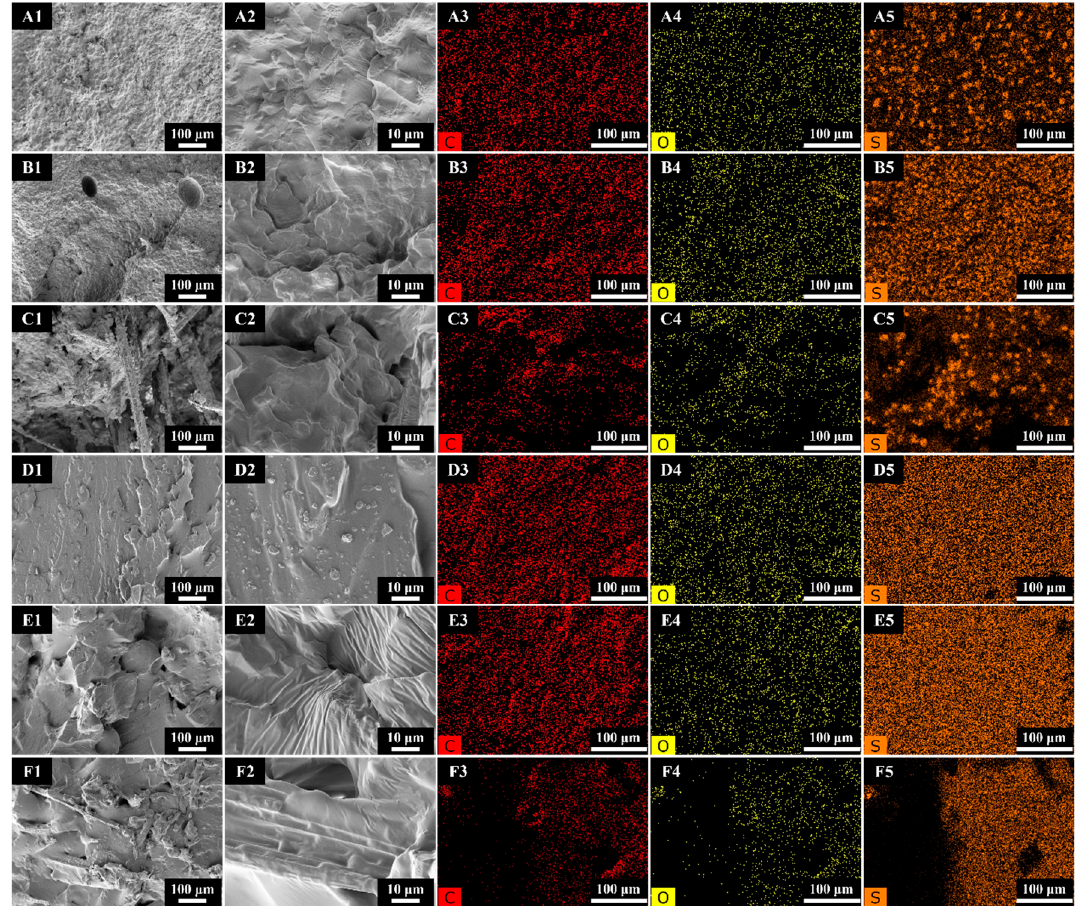
Figure 4. SEM image and element mapping of bio-based polysulfide composite. ( A1 – A5 ) 10.0 g CSO + 10.0 g S, ( B1 – B5 ) 10.0 g CSO + 10.0 g S + 2.0 g elm, ( C1 – C5 ) 10.0 g CSO + 10.0 g S + 1.0 g cattail, ( D1 – D5 ) 10.0 g CSO + 3.0 g S, ( E1 – E5 ) 10.0 g CSO + 3.0 g S + 0.45 g elm, ( F1 – F5 ) 10.0 g CSO + 3.0 g S + 0.3 g